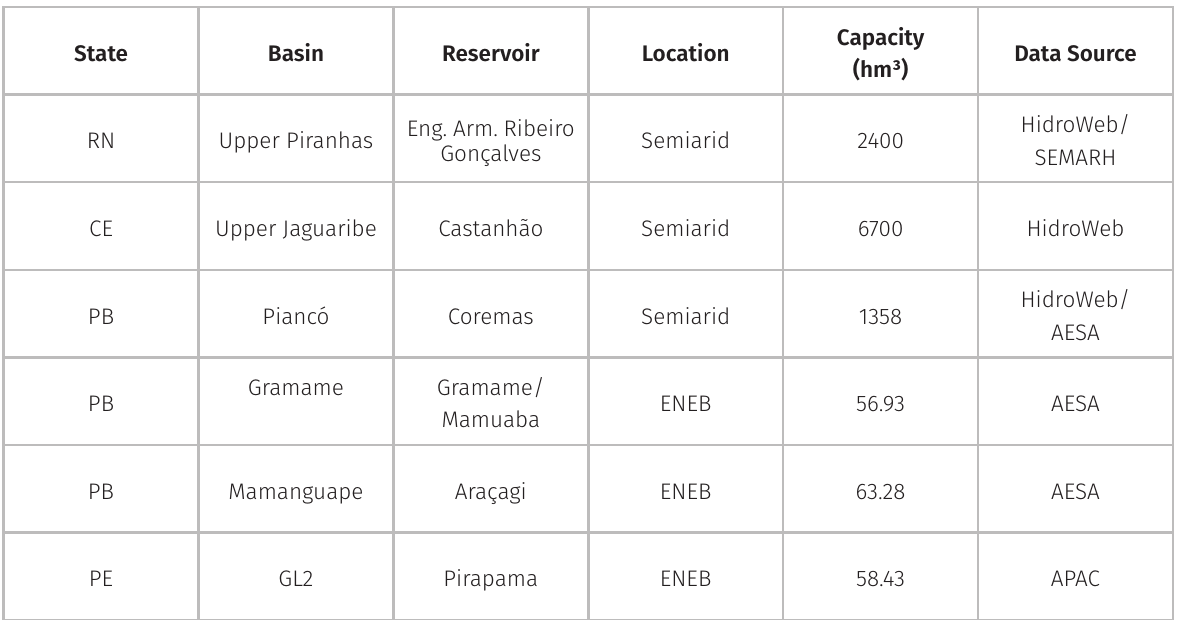
Table I. Water capacity of the six reservoirs